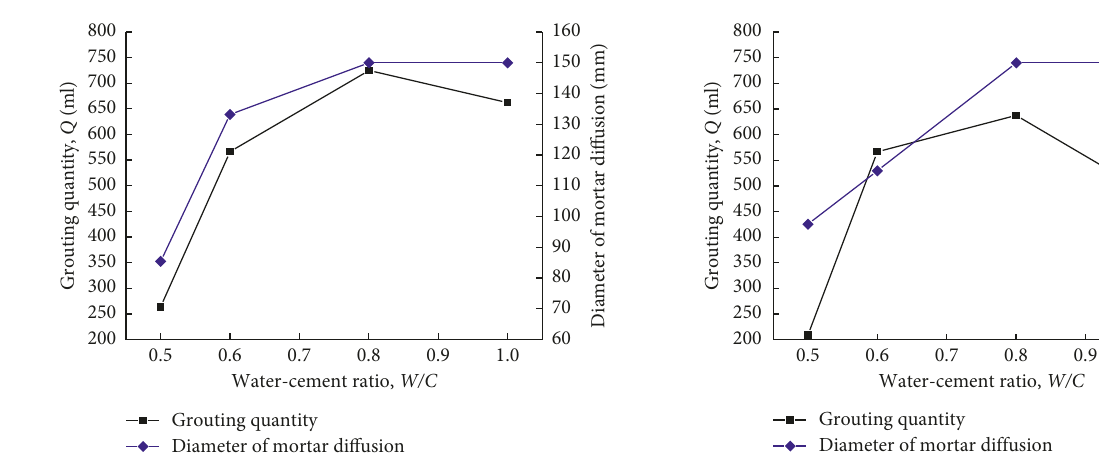
Figure 20: Characteristics of slurry diffusion ( P � 0.2MPa, k 3 � 0.93